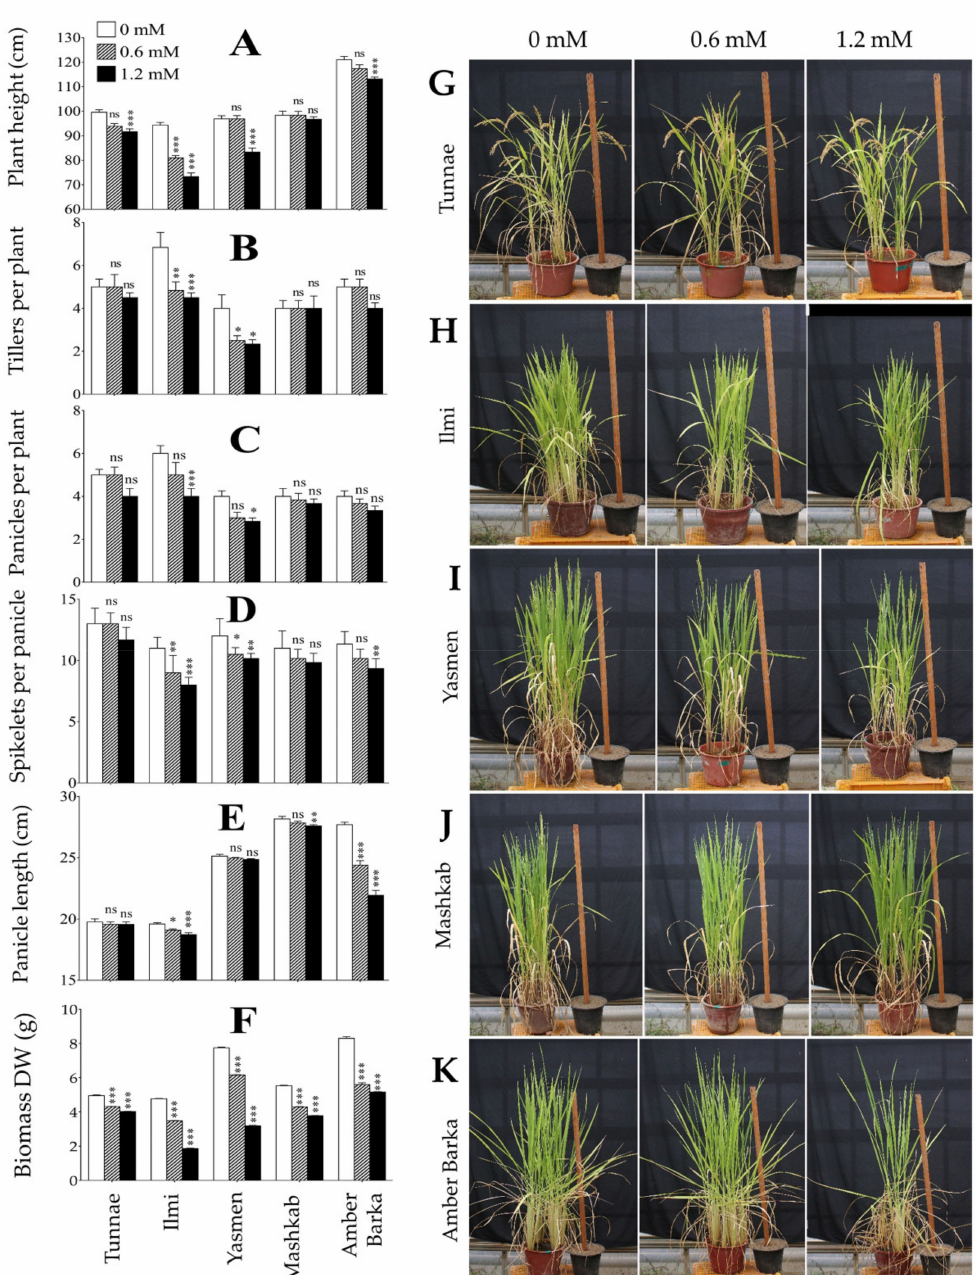
Figure 1. Changes in the agronomic traits of different rice cultivars under a gradient Pb concentrations. ( A ) Plant height, ( B ) number of tillers per plant, ( C ) number of panicles per plant, ( D ) number of spikelets per panicle, ( E ) panicle length, ( F ) biomass dry weight, and ( G – K ) visual phenotypes of five rice cultivars (Tunnae, Ilmi, Yasmen, Mashkab, and Amber Barka). Bars are mean values ± SE. Data are compared with their respective controls (untreated plants: 0 mM Pb). *** p < 0.001, ** p < 0.01, * p < 0.05, ns :